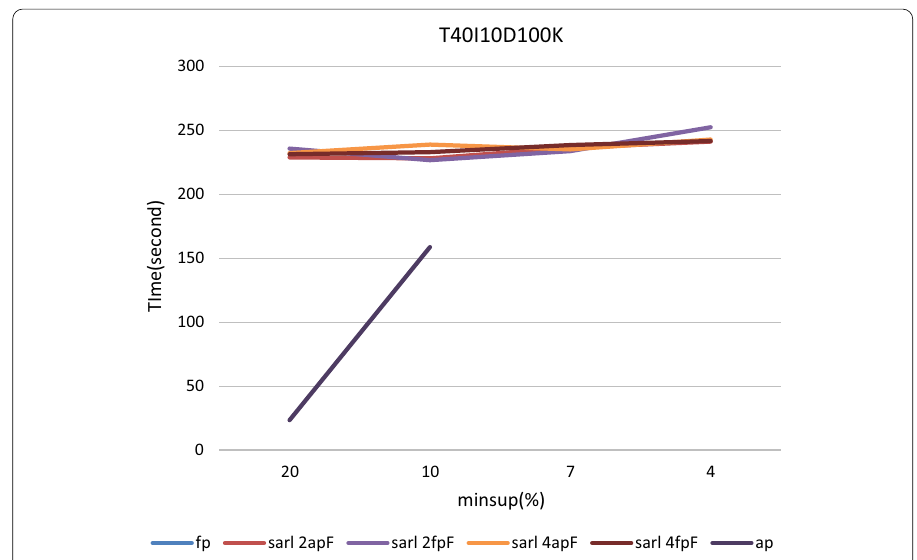
Fig. 10 Running times of different algorithms on the T40I10D100K dataset